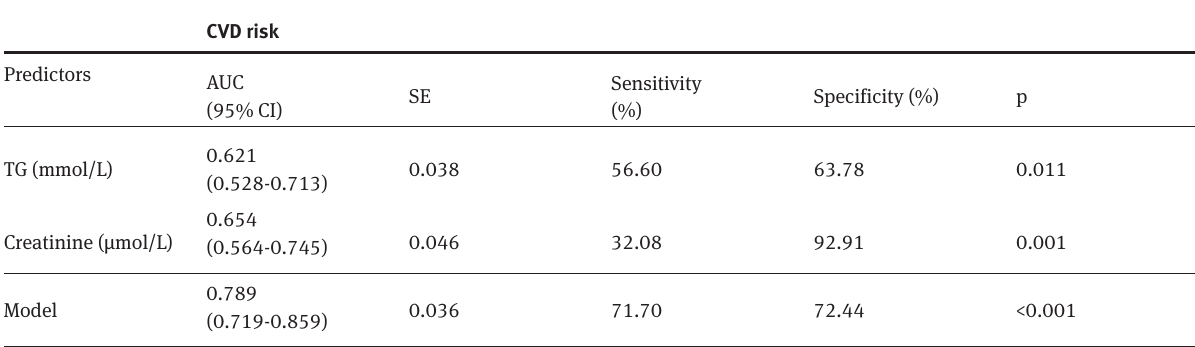
Table 5: ROC analysis for single parameter and model discriminatory abilities regarding CVD risk